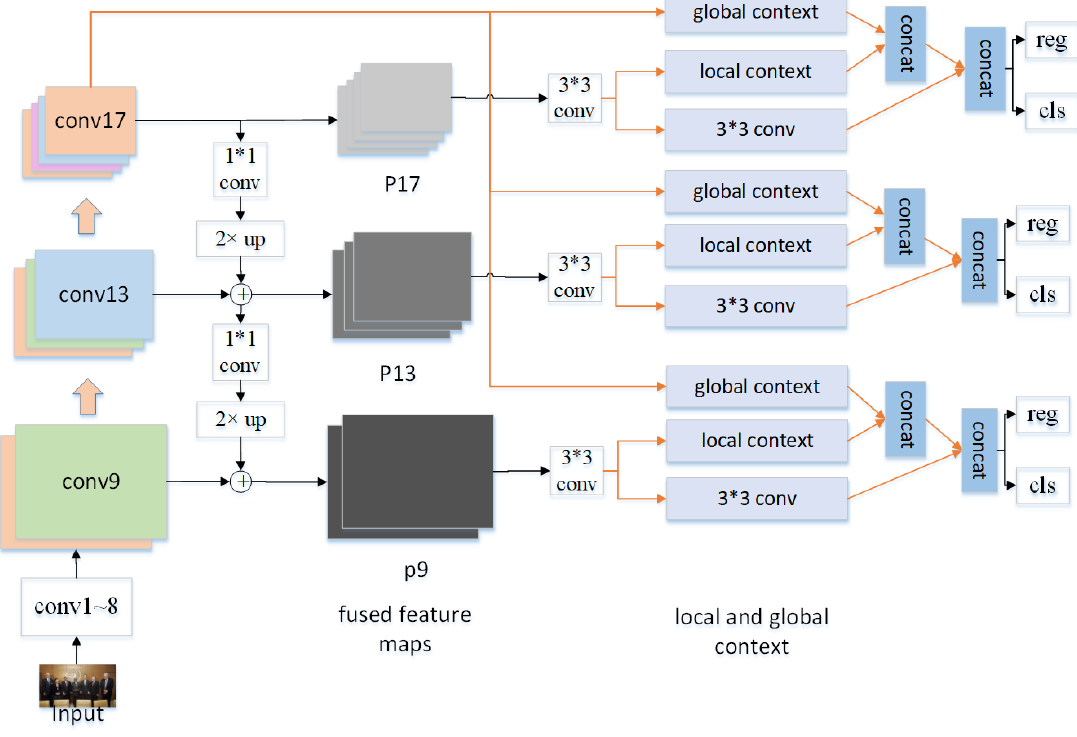
Figure 3. Overall architecture of our method.